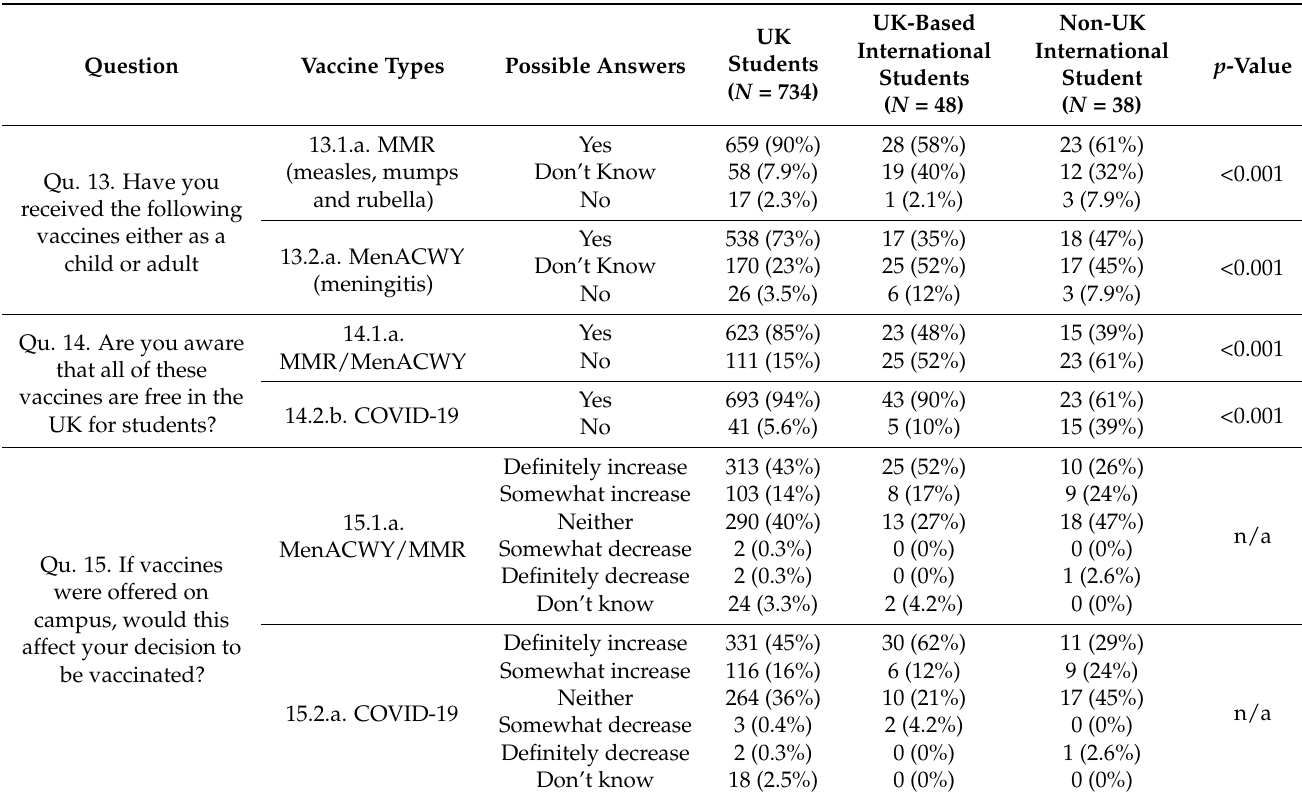
Table 3. Comparative knowledge and attitudes to on campus delivery of COVID-19, MMR and MenACWY